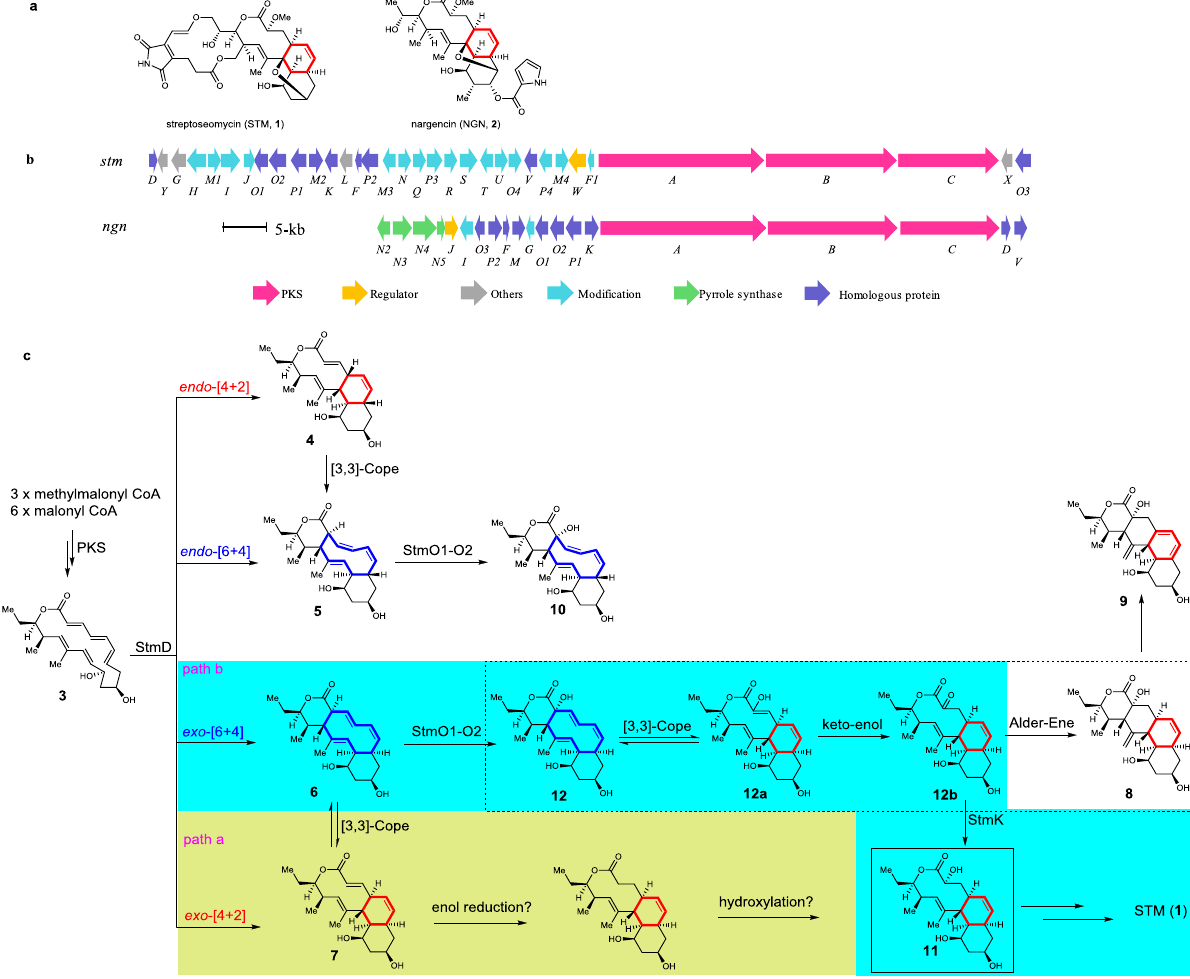
Fig. 1 Biosynthesis of streptoseomycin. a Structures of streptoseomycin ( 1 ) and nargenicin ( 2 ); b Genetic organization of the stm and ngn gene clusters; c biosynthetic pathway involved in polyketide part of STM biosynthesis. Path a (yellow background) is the original pathway using [4 + 2]-adduct as the intermediate. Path b (blue background) is the revised pathway starting from [6 + 4]-adduct. Steps in the dashed region are nonenzymatic